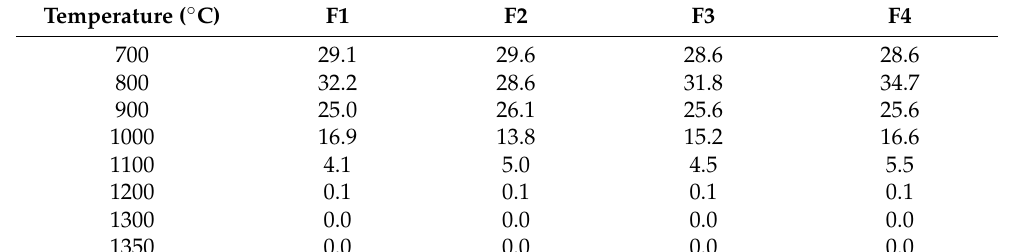
Figure 2. TG curves of raw materials.